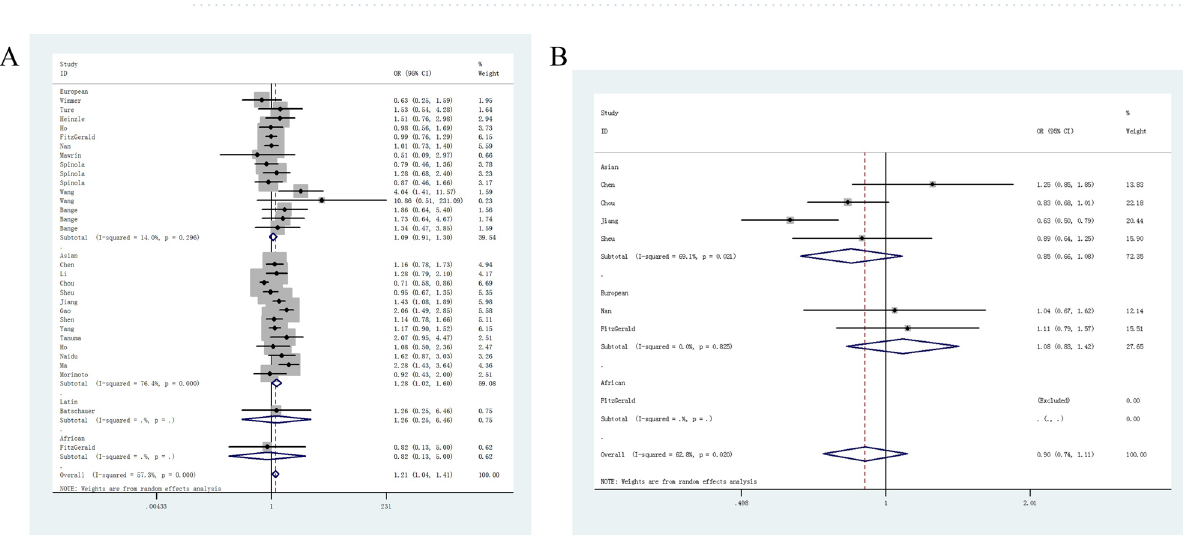
Figure 3. Stratified analysis by ethnicity between FGFR4 G388R ( A ), V10I ( B ) polymorphisms and cancer risk (recessive genetic model,